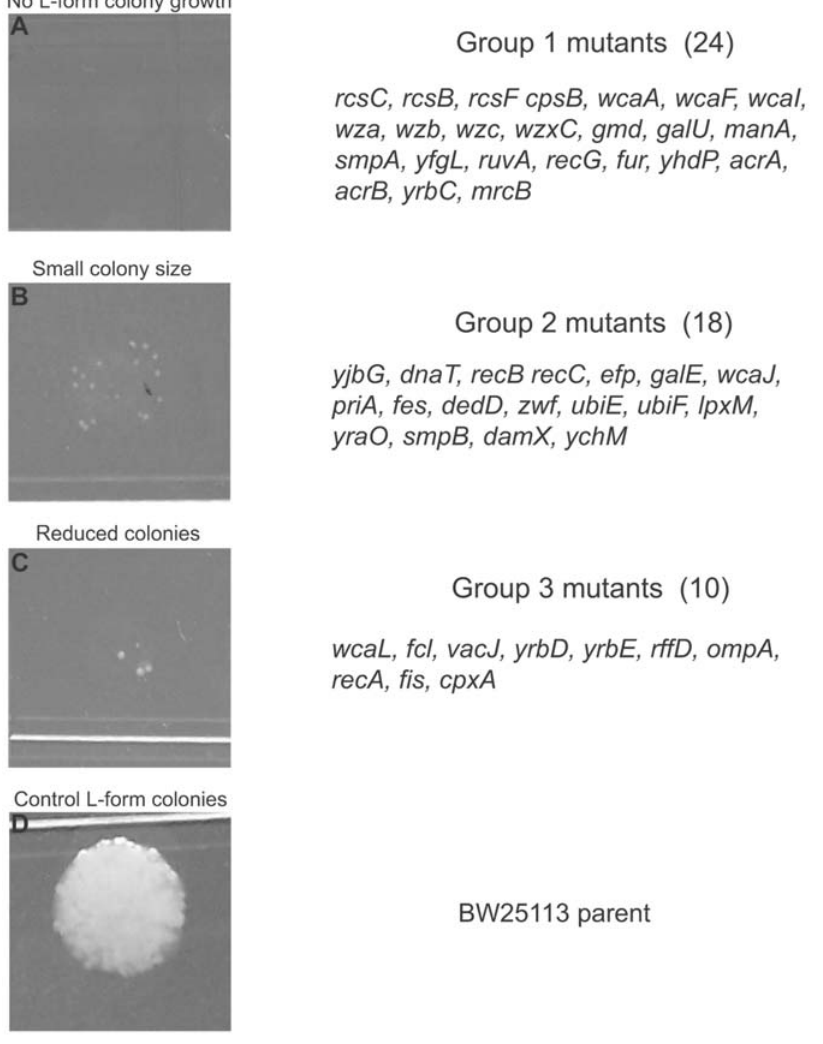
Figure 3. L-form colony phenotypes exhibited during screening of the E.coli Keio deletion mutant library. A No growth phenotype (Group 1) displayed by identified mutants on LIM. B Small colony size phenotype (Group 2) displayed by identified mutants on LIM. C Mutants showing reduced colony numbers (Group 3) on LIM. D E. coli BW25113 parent displaying numerous mucoid L-form colonies on LIM.